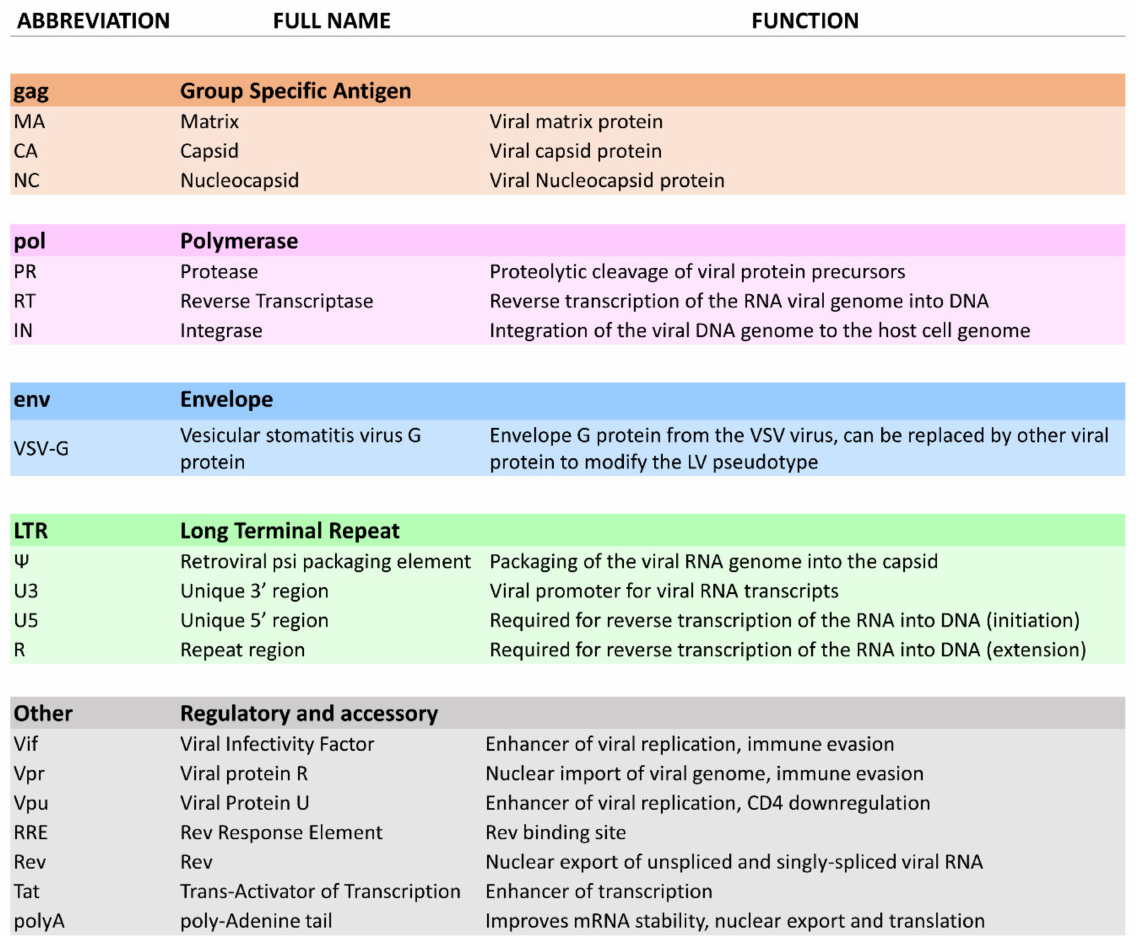
Figure 1. The three generations of LV plasmid systems. Each Generation of LV vector is presented with the plasmid constructs necessary for its production and with the genes each plasmid